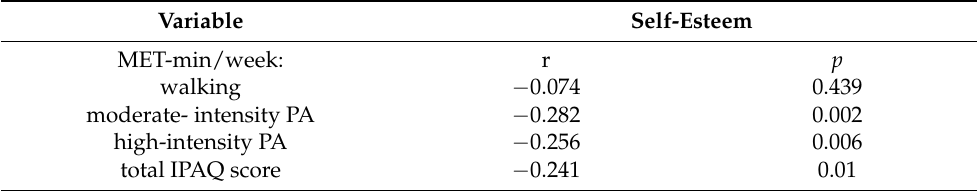
Table 6. Correlation between physical activity intensity and